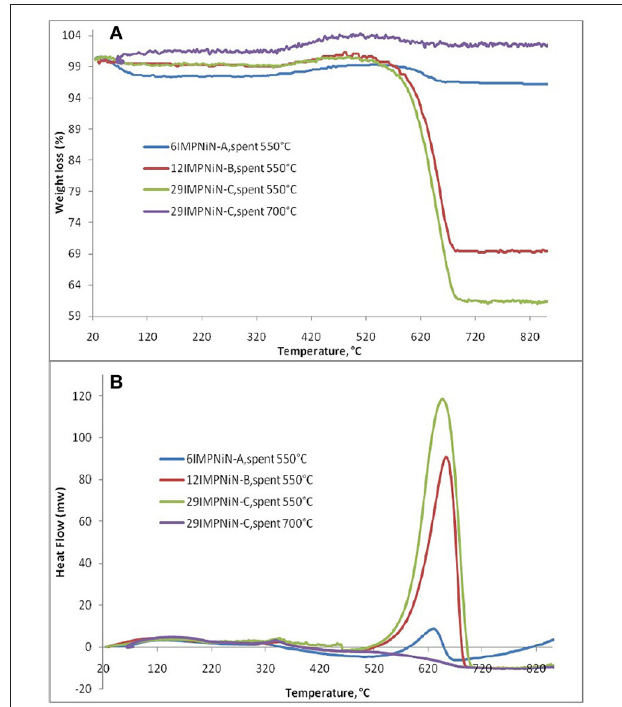
FIGURE 4 | TGA (A) /DSC (B) analysis of: 6IMPNiN-A spent at 550 ◦ C, 12IMPNiN-B spent at 550 ◦ C, 29IMPNiN-C spent at 550 ◦ C, and 29IMPNiN-C spent at 700 ◦ C samples.